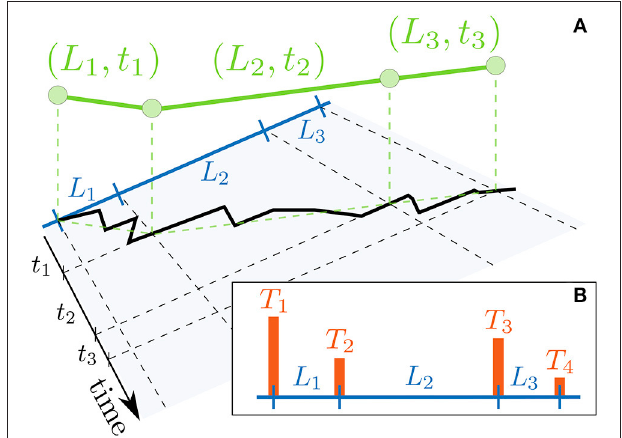
FIGURE 1 | Schematic of the system. (A) Example of a one dimensional compartmentalized environment, with compartment size L and boundary transmittance T . Higher boundaries represent lower transmittance. For simplicity we plot the meshwork as formed by the segments of a line. (B) Motion of the particle in such environment. The dark line represents the microscale description of the motion and the green one indicates its mesoscale description, in this case a Lévy walk with steps given by their length and flight time ( L , t